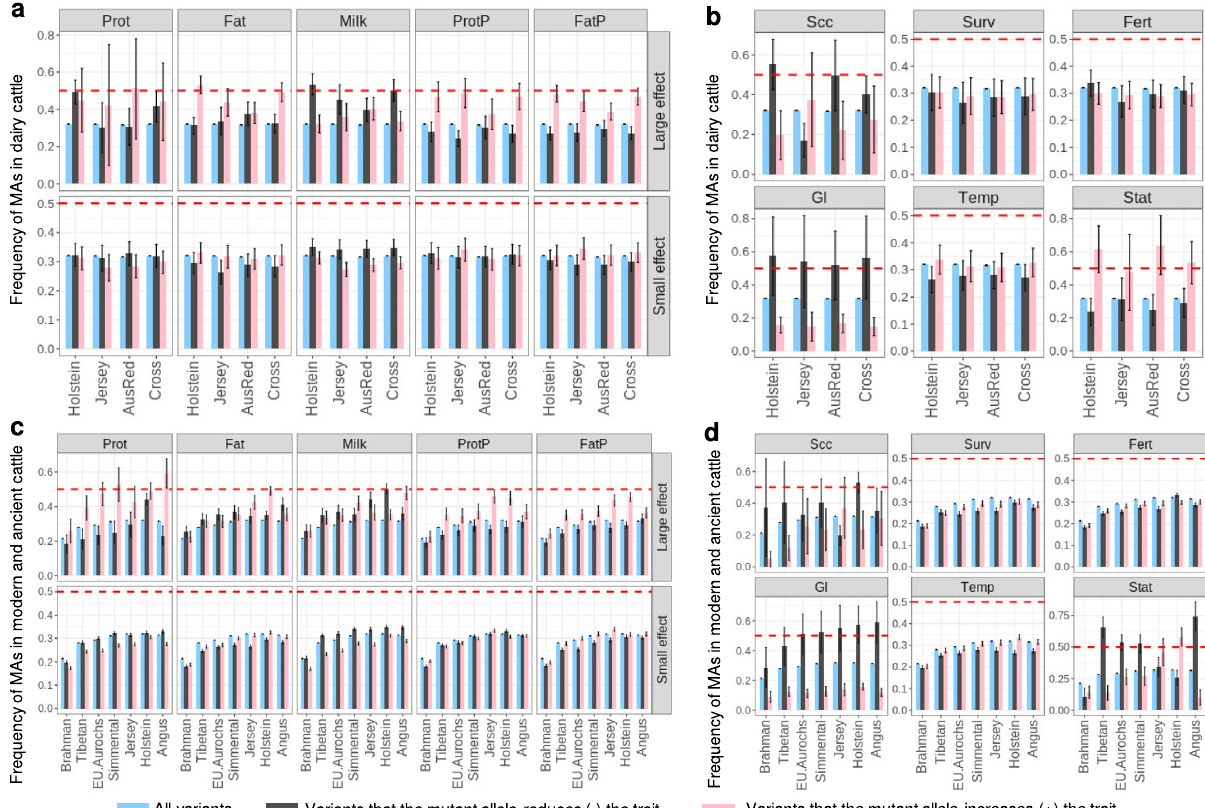
Fig. 3 The allele frequency of mutant alleles (MAs) in cattle. The average frequency of variants associated with different traits is shown with standard error bars based on LD-clumped variants. All variants included the 7.9 M variants where mutant alleles were assigned. The red dashed line represents the frequency of 0.5. In the dairy cattle section ( a , b ), 90,627 Holstein, 13,465 Jersey, 3358 Australian Red (AusRed) and 4649 crossbreds were used. In the ancient and modern cattle ( c , d ), 210 Brahman, 25 Tibetan, 10 Eurasian Aurochs, 242 Simmental, 95 Jersey, 840 Holstein and 287 Angus were used. For b , d , results for survival (Surv), fertility (Fert) and temperament (Temp) were from small-effect MAs while results for somatic cell count (Scc), gestation length (Gl) and stature (Stat) were from medium-effect